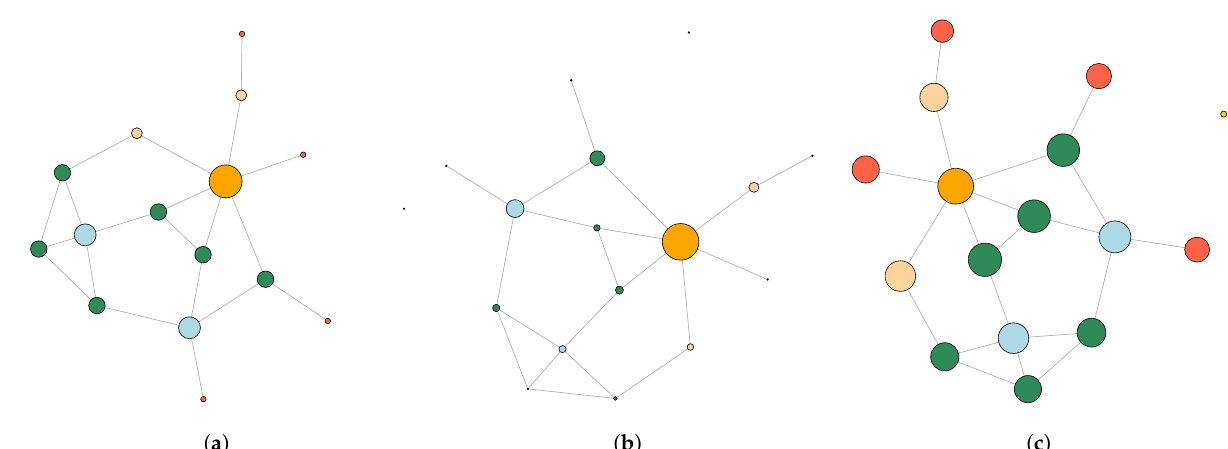
Figure 1. This figure illustrates three different centrality measures for a sample graph. The sizes of the vertices are proportional to the respective measures. All measures are normalized such that the maximal values are equal for all measures. Schemes follow the same formatting. The respective measures are: ( a ) Degree centrality. ( b ) Betweenness centrality. ( c ) Closeness